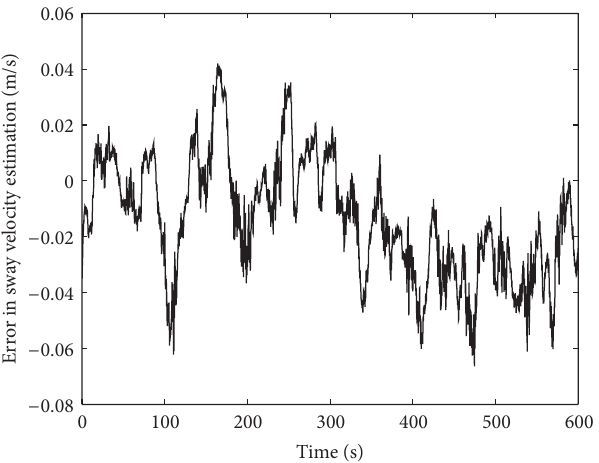
Figure 9: Error in the identification of the sway velocity, that is, difference between the sway velocity obtained in simulation and in the real setup.